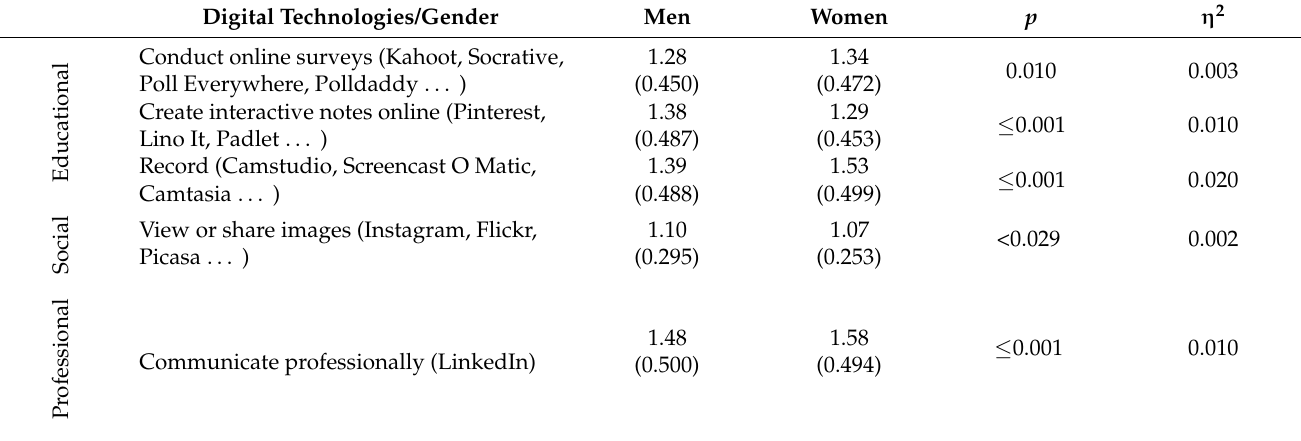
Table 3. Frequency of use of digital technologies according to gender as a fixed